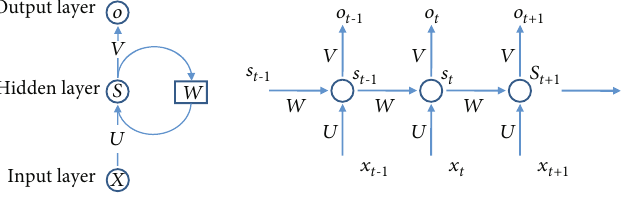
Figure 7: The principle of recurrent neural network.